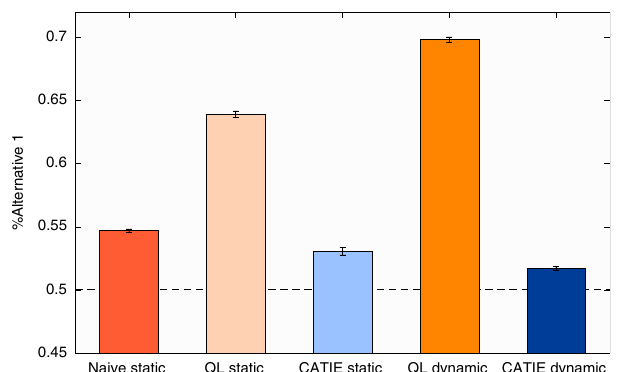
Fig. 2 The effect of reward schedule on the bias of a QL agent. Red, orange and blue bars denote the naïve schedule, and schedules optimized assuming a QL agent and a CATIE agent, respectively. Light colors denote static schedules whereas dark colors denote a dynamic reward schedule (see Supplementary Methods). Dashed line denotes chance level and error- bars are standard errors of